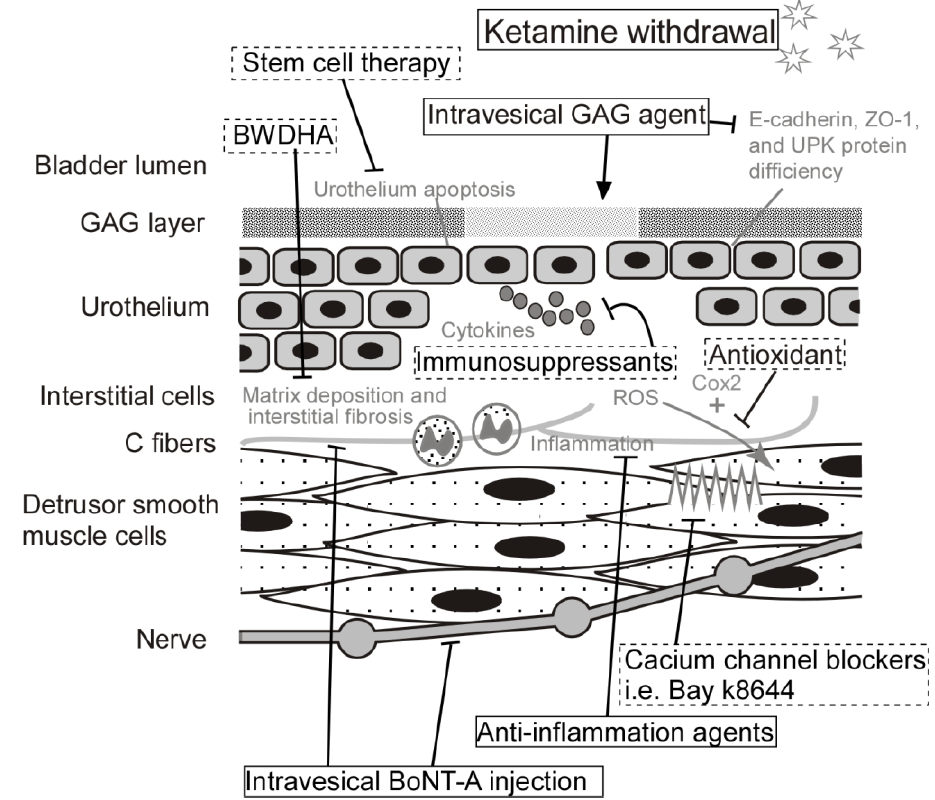
Figure 3. Schematic of therapeutic targeting strategies contains current medications already used for KC patients and potential therapies need further studies in the future (dash-line boxes). KC: ketamine-induced cystitis, BWDHA: Ba-Wei-Die-Huang-Wan, GAG: glycosaminoglycan, ZO-1: Zonula occludens-1, UPK: Uroplakin, ROS: reactive oxygen species, COX2: cyclooxygenase-2, BoNT-A: botulinum toxin-A.